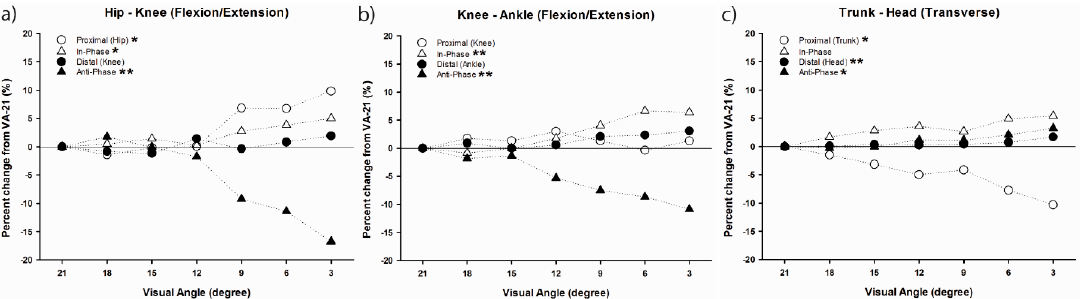
Figure 7. Mean percent change for the coordination patterns in lower extremity joint couples in the sagittal plane, hip–knee ( a ) and knee–ankle ( b ), and upper extremity segment couples in transverse plane, trunk-head ( c ), showing the significant effect of visual condition from VA-21. Main effect of visual condition (* p < 0.05; ** p < 0.01). Positive numbers indicate increased value in percentage from VA-21, and vice versa (Lim et al. [59]).